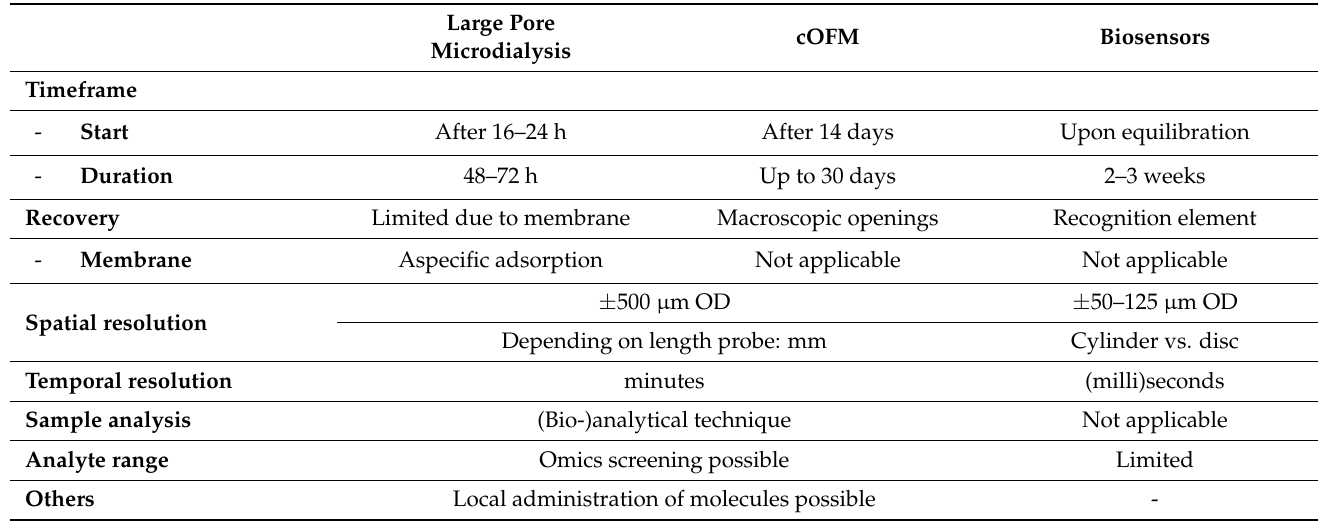
Table 1. Overview of strengths and limitations influencing the possible applications of the three techniques. Large Pore cOFM Microdialysis